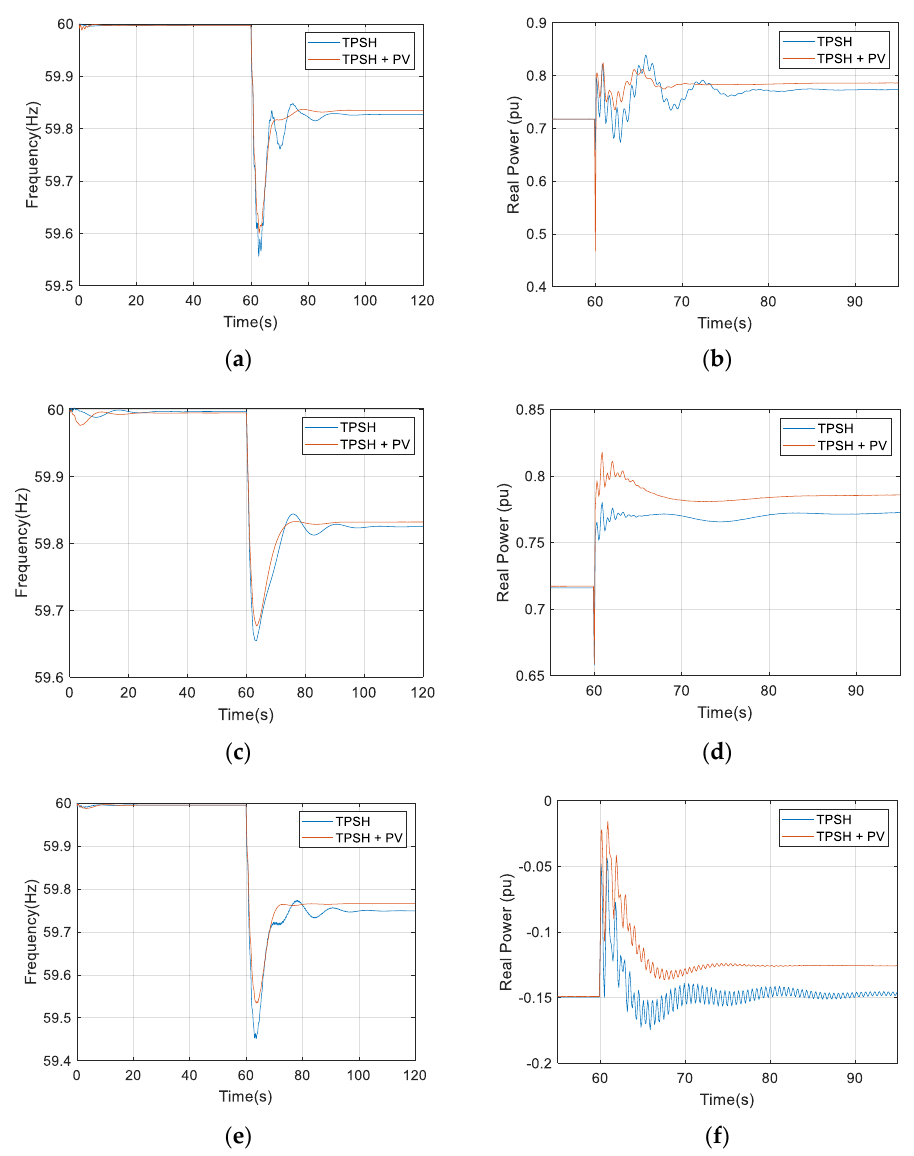
Figure 14. FFR results of frequency and real power output: ( a , b ) generation mode, ( c , d ) pump mode with HSC, and ( e , f ) pure pump